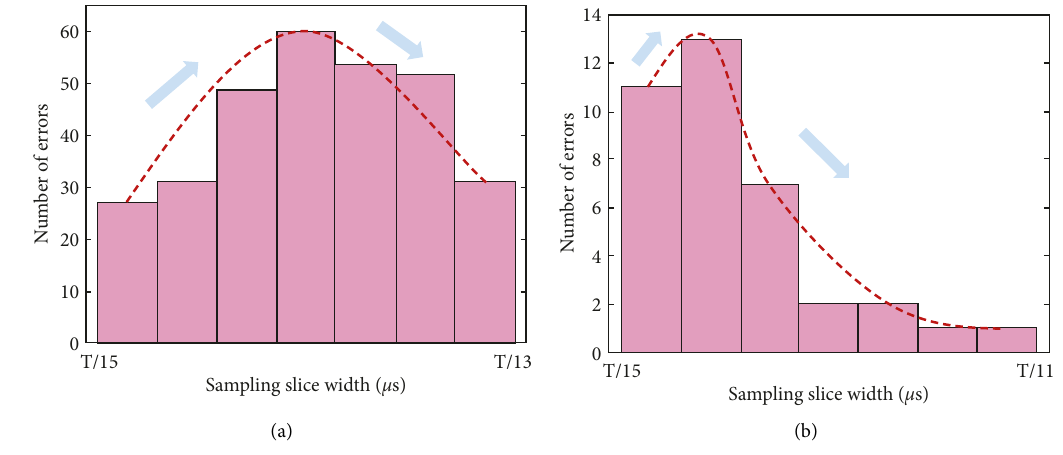
Figure 9: T W distribution of error samples. (a)